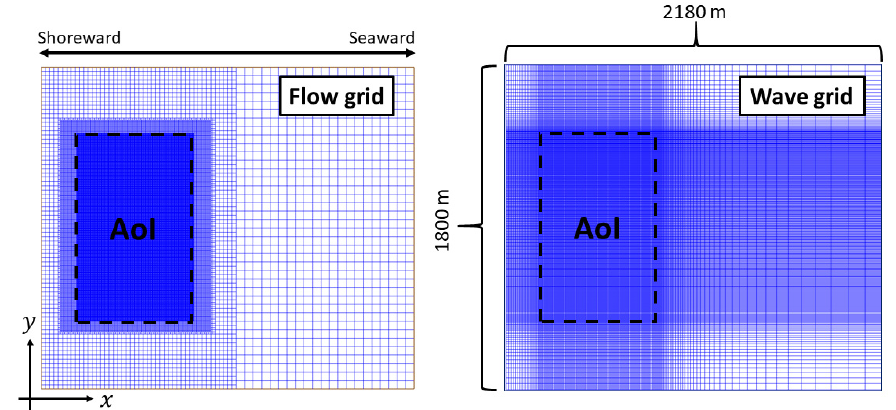
Figure 7. Computational grids used for the CMS-Flow and CMS-Wave models.